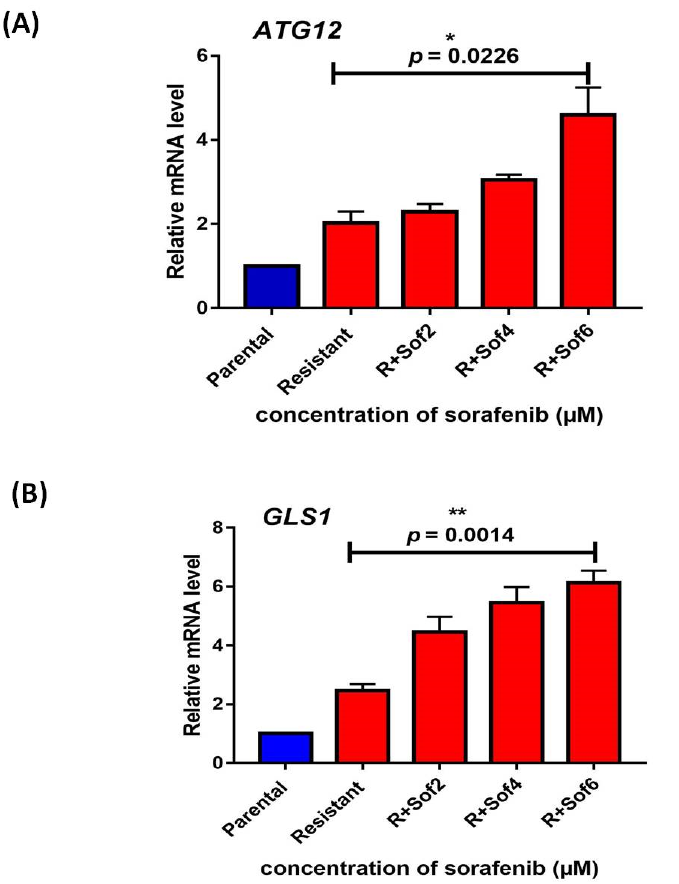
Figure 8. ( A ) ATG12 expression analysis ( B ) GLS1 expression analysis in parental and sorafenib resistant HepG2 cells [R; sorafenib resistant HepG2 cells; Sof: sorafenib with 2 µM; 4 µM; 6 µM] (* p ≤ 0.05); (** p ≤ 0.01).